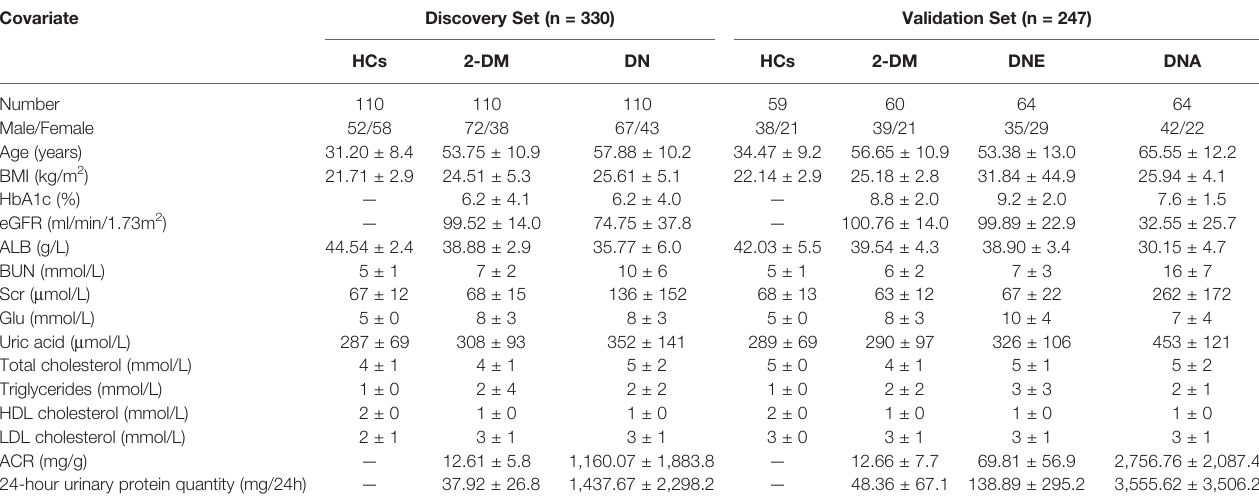
TABLE 1 | Characterization of the study